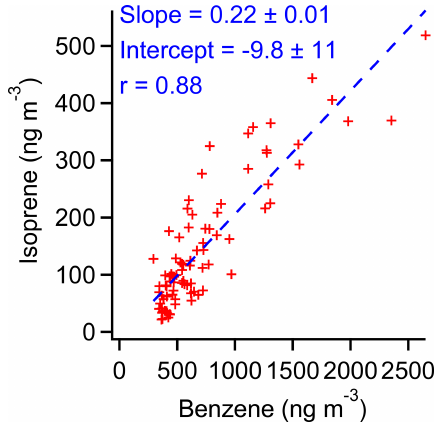
Figure 18. Correlation of isoprene and benzene between 22:00 and 05:30LT, when biogenic production of isoprene is expected to be